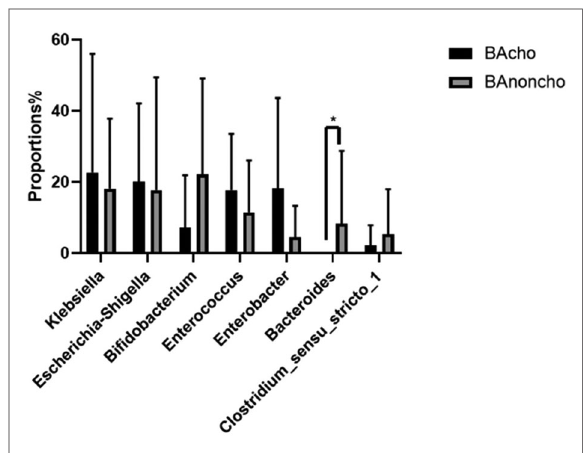
FIGURE 4 Wilcoxon rank-sum test bar plot on genus level between BAcho and BAnoncho. There was no difference on Klebsiella, Esherichia-Shigella, Bi fi dobacterium, Enterococcus, Enterobacter, Clostridium- sensu - stricto -1 between BAcho and BAnoncho group. Compare to BAcho, Bacterouides was signi fi cancely increased in BAnoncho. (* p